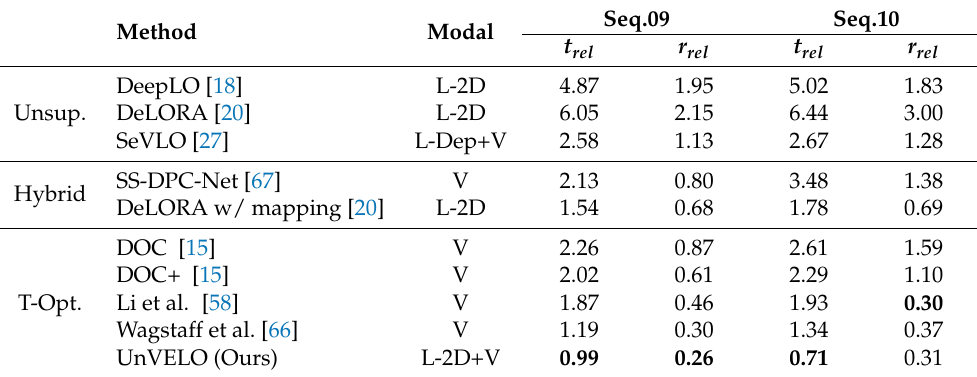
Table 4. Comparison of the proposed method with the SoTA trained on Seq.00-06 and tested on Seq.07-10 of KITTI. The Modal column denotes the modalities of network inputs, where “L” stands for LiDAR and “V” stands for visual.